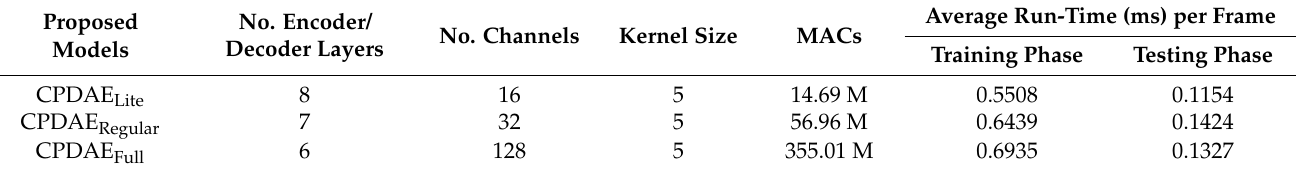
Table 5. Components of the Proposed Models.